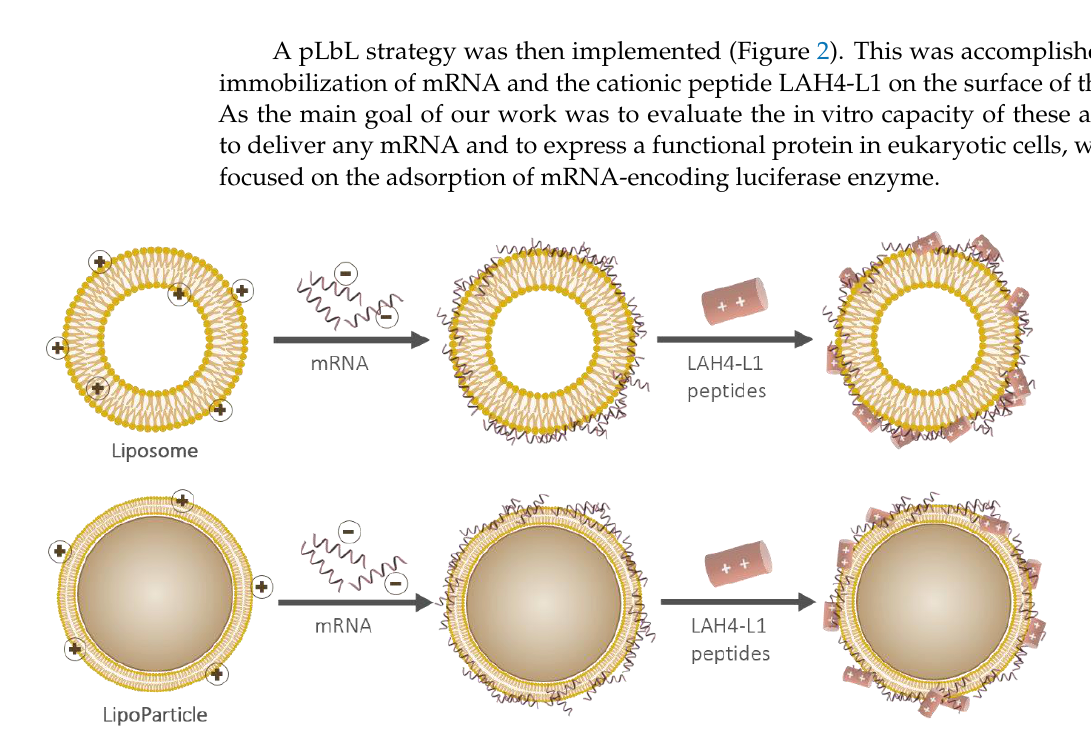
Figure 2. Schematic representation of the particulate layer-by-layer formulation strategy used to successively adsorb mRNA and LAH4-L1 on either a liposome (top) or a LipoParticle (bottom). Note that the scale proportions are not re- spected. Table 2. Characterization of Fluc mRNA adsorbent formulations prepared through particulate layer-by-layer (pLbL) strategy using either liposomes or LP as carriers (ratio mRNA/LAH4-L1 = 1/20 w / w ). Results are represented as mean ± SD of different batches ( n = 3).